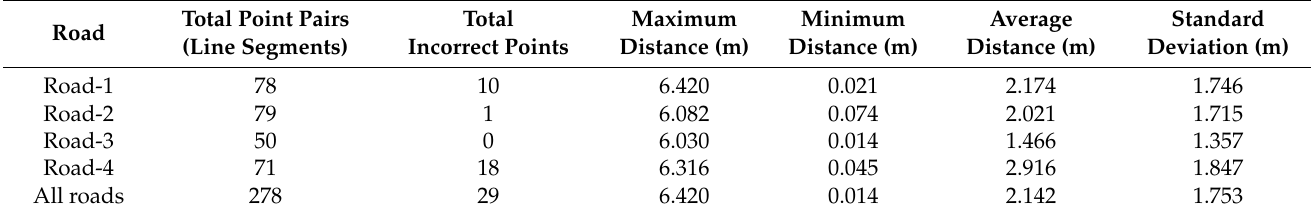
Table 4. Assessment of the ATP-ROAD-extracted results for Area-I using distance